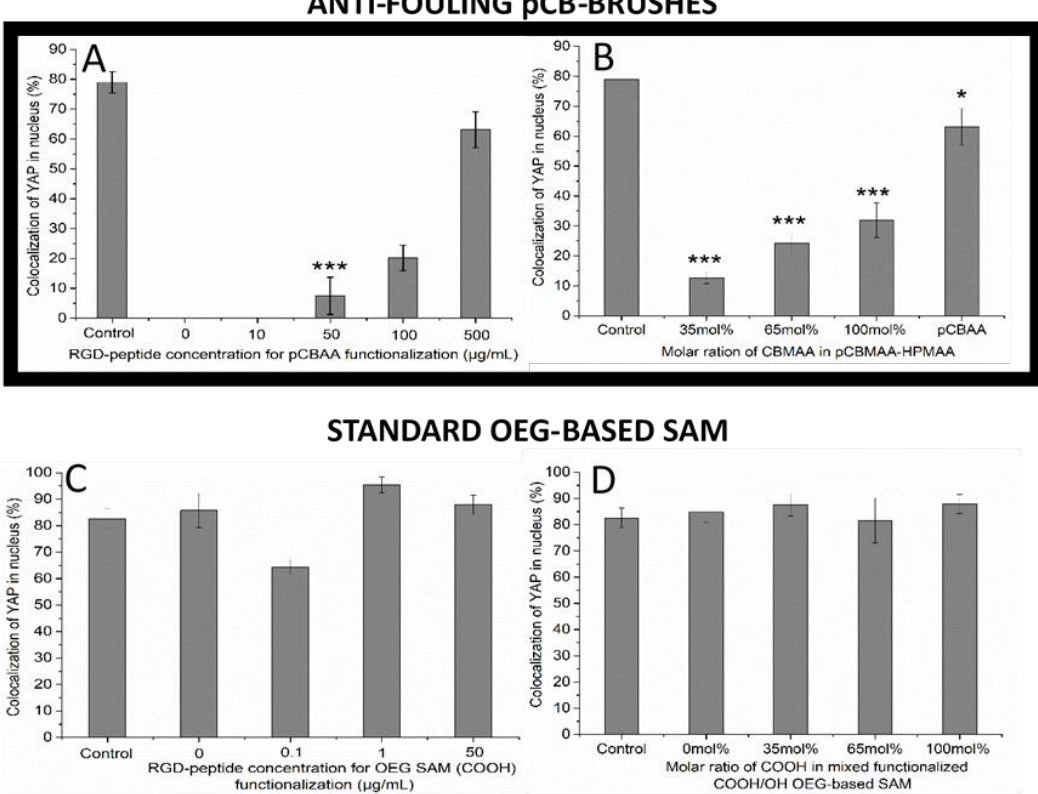
Figure 3. Colocalization of the YAP in the nucleus in cells growing on different RGD-functionalized surfaces. ( A ) Antifouling pCBAA coatings functionalized by solutions with different concentrations of RGD peptides (method A-1 in Figure 1). ( B ) Set of RGD-functionalized copolymer p(CBMAA- ran -HPMAA) antifouling coatings with increasing contents of functionalizable pCBMAA (method B-1 in Figure 1). ( C ) RGD-functionalized standard carboxy-ended OEG SAM (HS-(CH 2 ) 11 -(EG) 6 -OCH 2 -COOH)